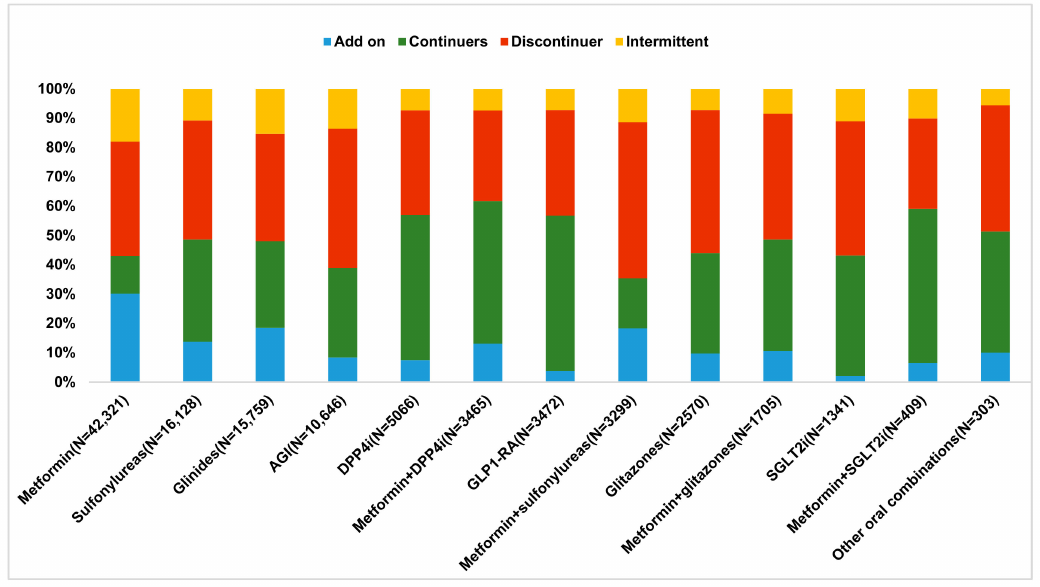
Figure A4. Distribution (%) of continuers, add on, discontinuers and intermittent within the first year of treatment among incident treatments, stratified by antidiabetic molecule / class. Legend: AGI = alpha-glucosidase inhibitors; DPP4i = dipeptidyl peptidase-4 inhibitors; GLP-1RA = glucagonlike peptide-1 receptor antagonists; SGLT2i = sodium–glucose linked transporter 2 inhibitors; Other oral combinations = fixed-dose combinations of glitazones + DPP4i and glitazones + sulfonylureas. All incident AD treatments with at least 12 months of follow-up were